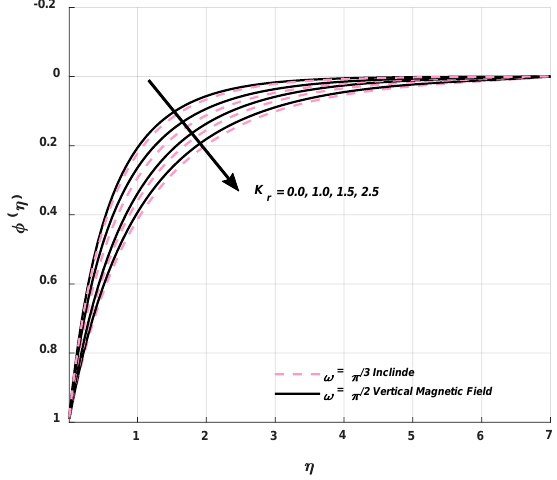
Figure 15. Impact of K r on φ ( η ) .